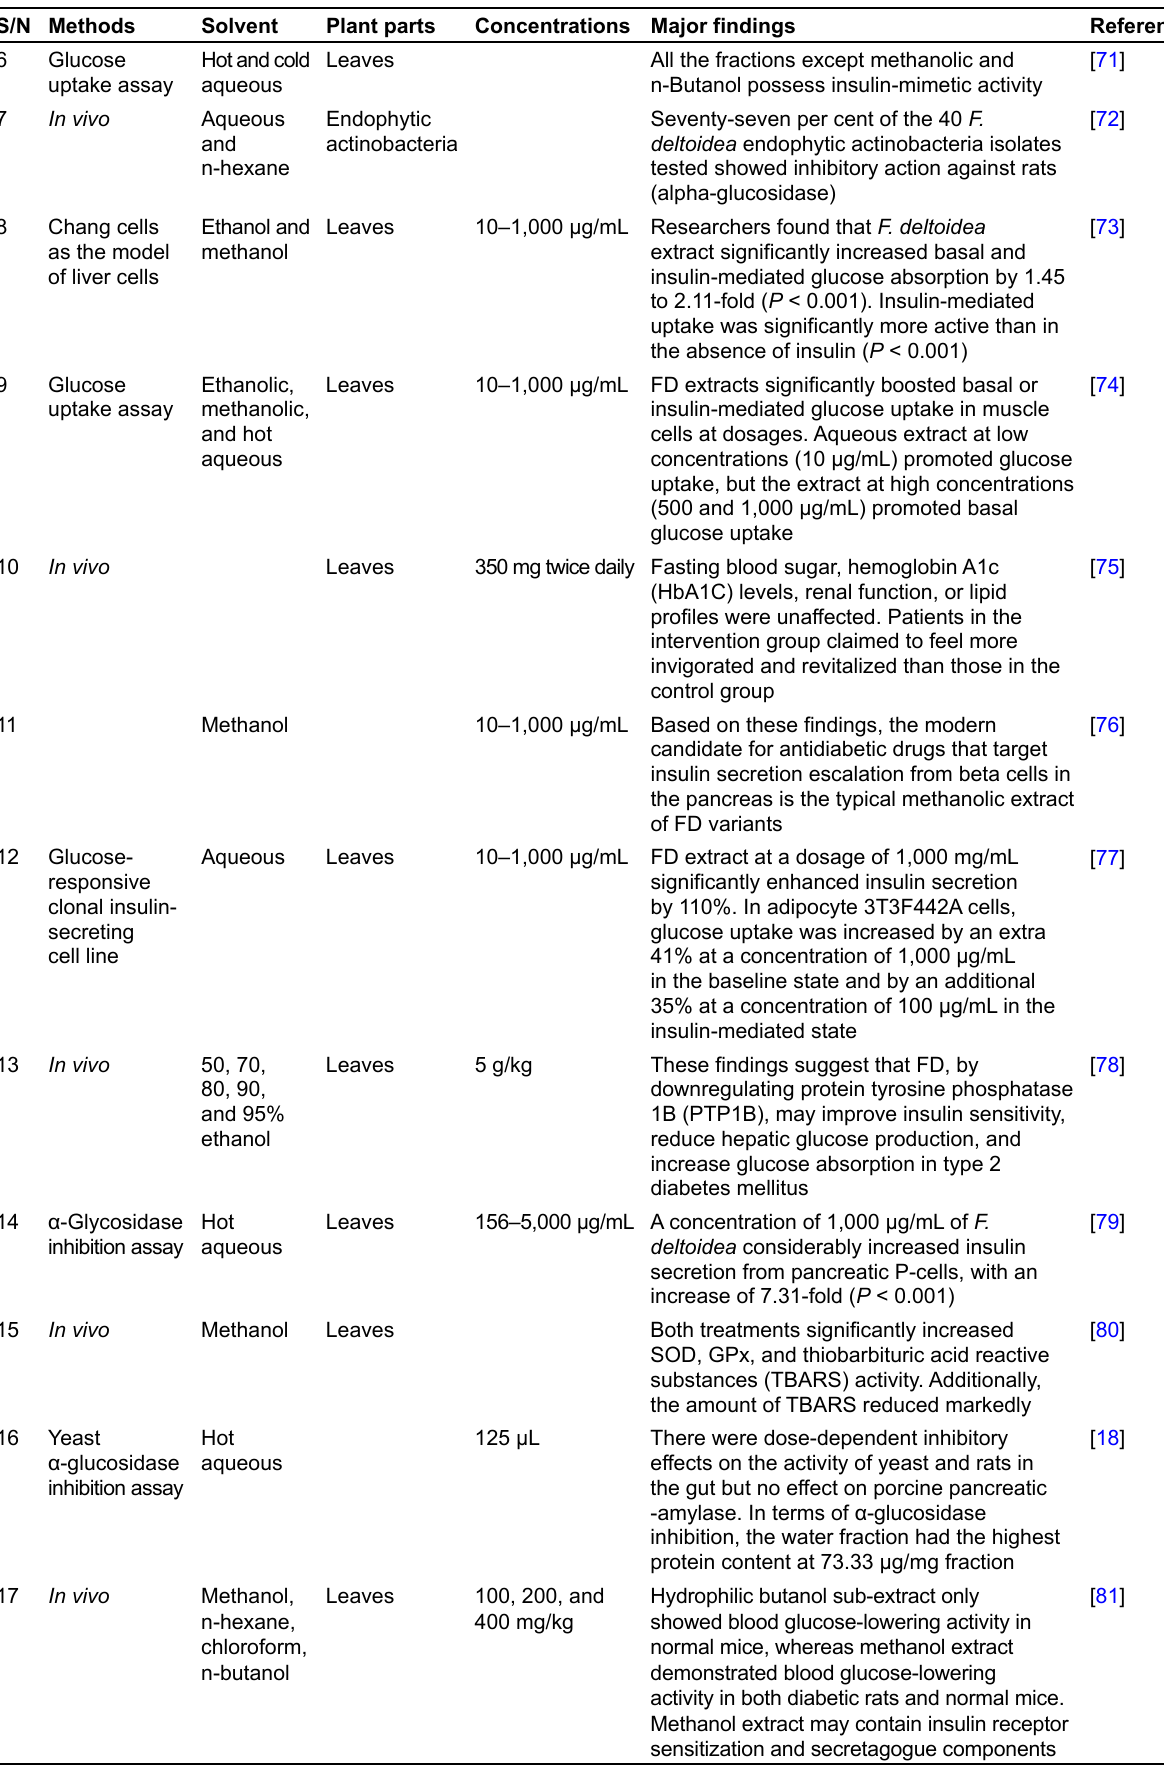
Table 4. FD effects on the endocrine system ( continued ) S/N